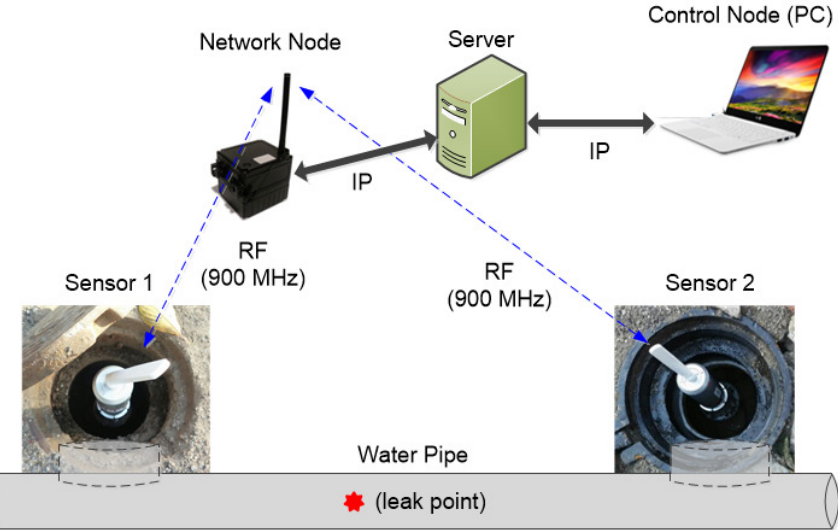
Figure 7. Leak detection system for field measurements.